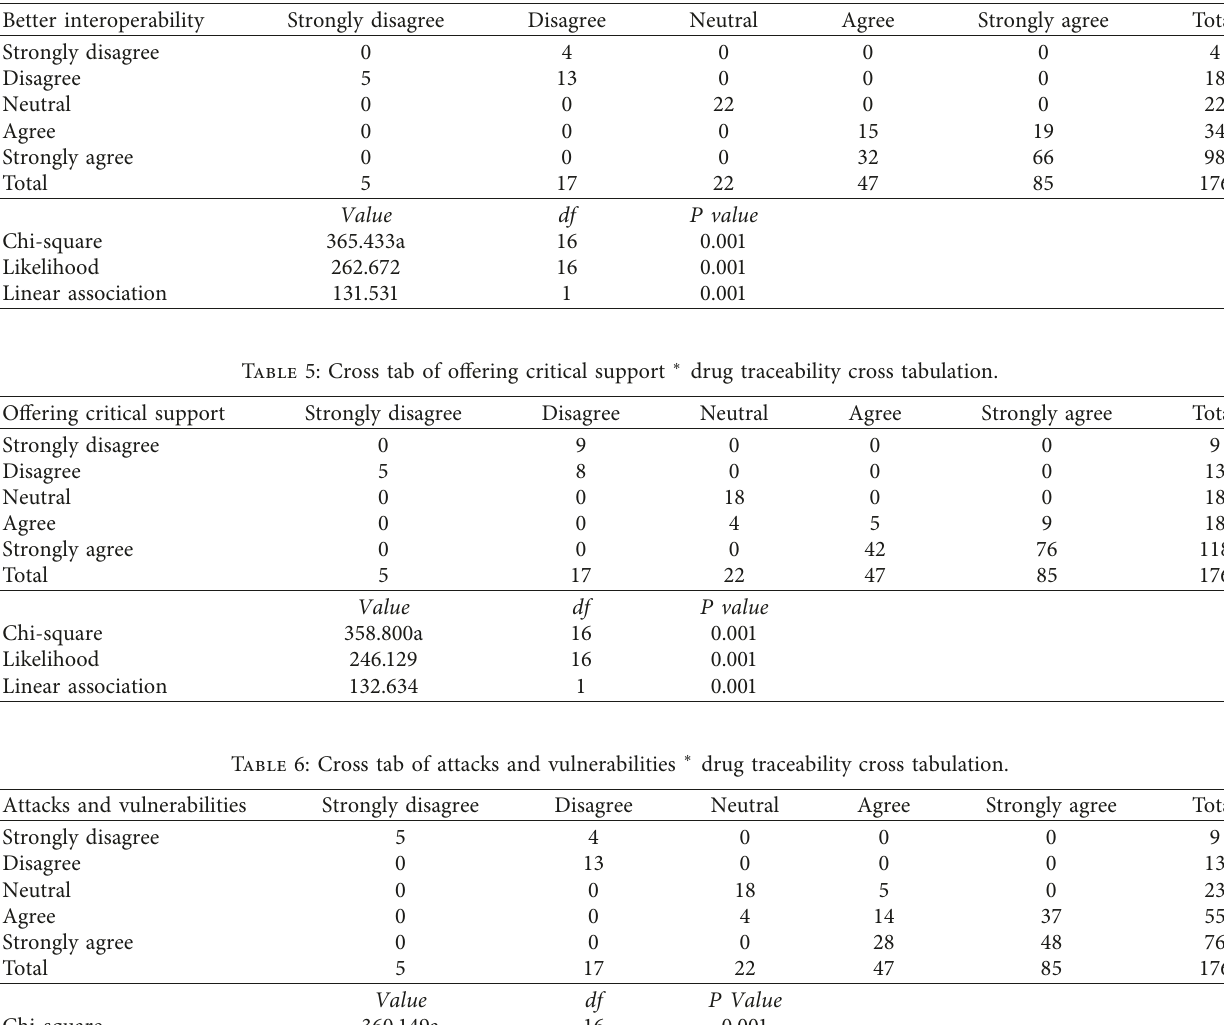
Table 4: Cross tab for better interoperability ∗ drug traceability in food products cross tabulation.